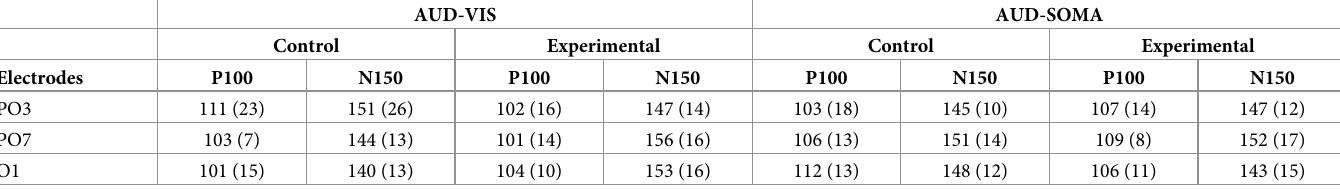
Table 1. Mean (and standard deviation) latencies (in ms) for the peaks used in the CSD- VEP calculation. AUD-VIS AUD-SOMA Control Experimental Control Experimental